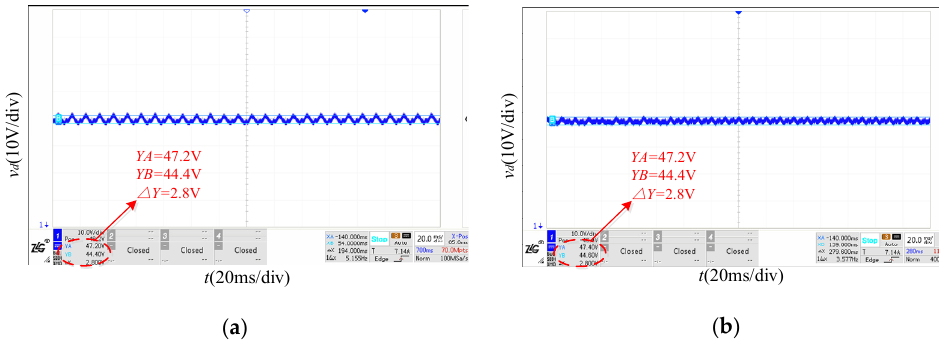
Figure 15. Capacitor voltage waveforms in line frequency cycle when φ = 0°: ( a ) traditional modulation strategy; ( b ) improved modulation strategy.